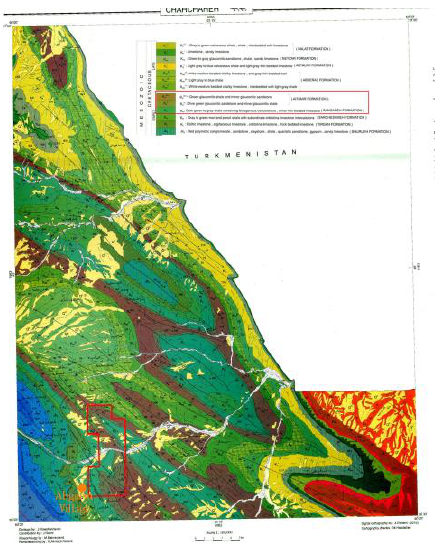
Figure 2. Location of the study area (red polygon) on Chahchahe geological map with 100.000 scale (geological survey of Iran 2010).